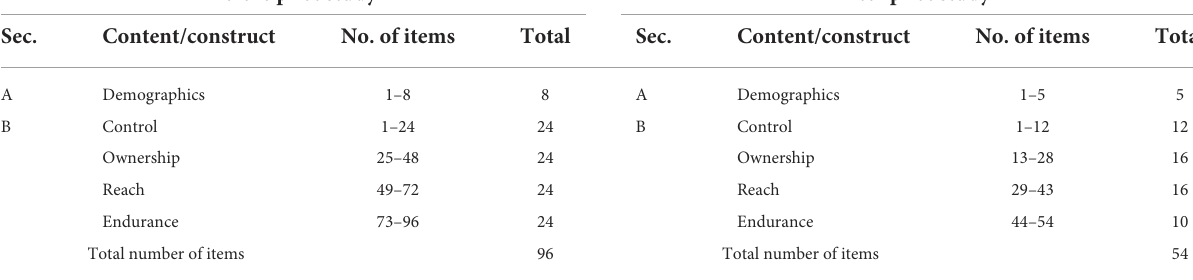
TABLE 2 Number of items—before and after pilot study. Before pilot